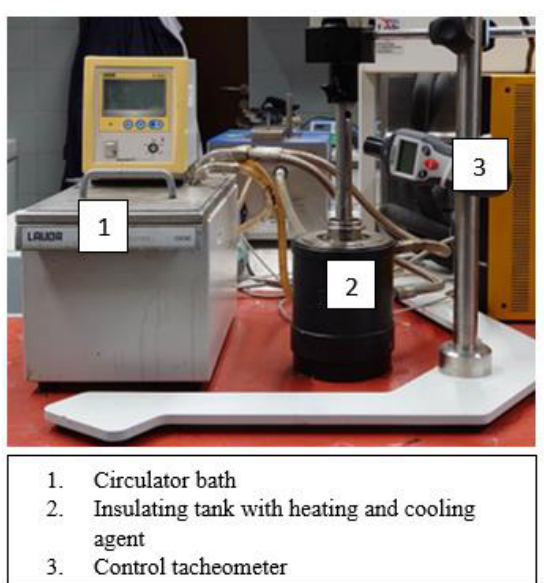
Figure 2. System for bitumen modification with